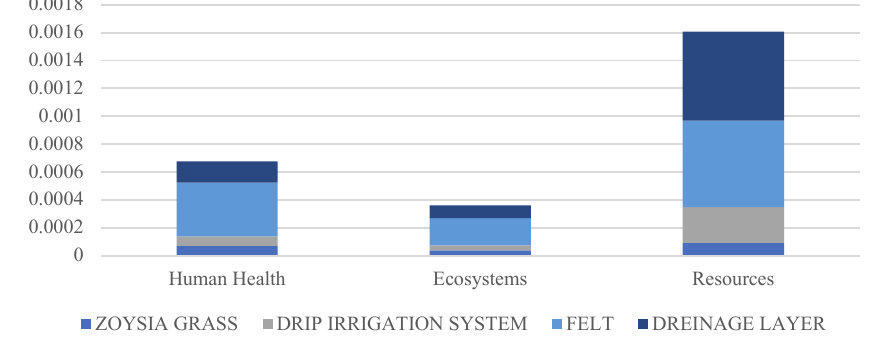
Fig. 4. Normalised impacts. Method: ReCiPe Endpoint (H) V1.11 / Europe ReCiPe